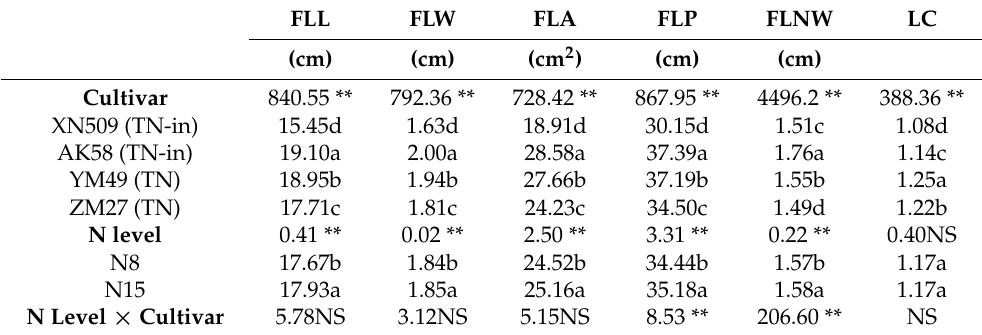
Table 3. Flag leaf morphological traits of two N-efficient and two N-inefficient winter wheat varieties under different N levels.